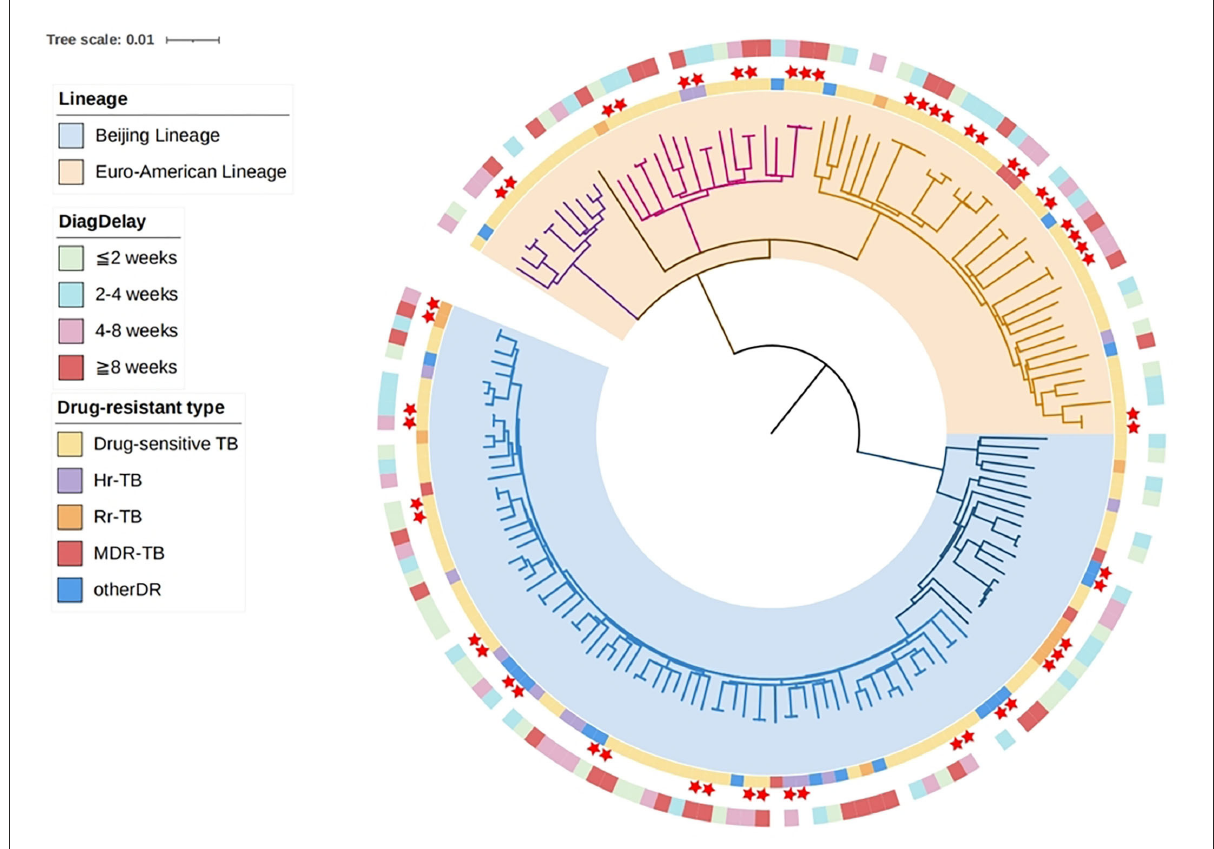
FIGURE2 Phylogenetic tree and drug resistance spectrum of 161 tuberculosis strains in